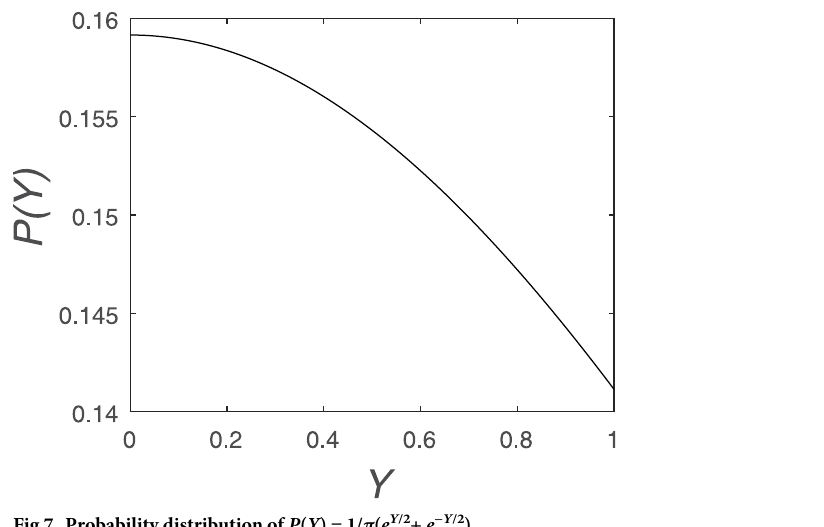
Fig 7. Probability distribution of P ( Y )= 1/ π ( e Y /2 + e − Y /2 ).